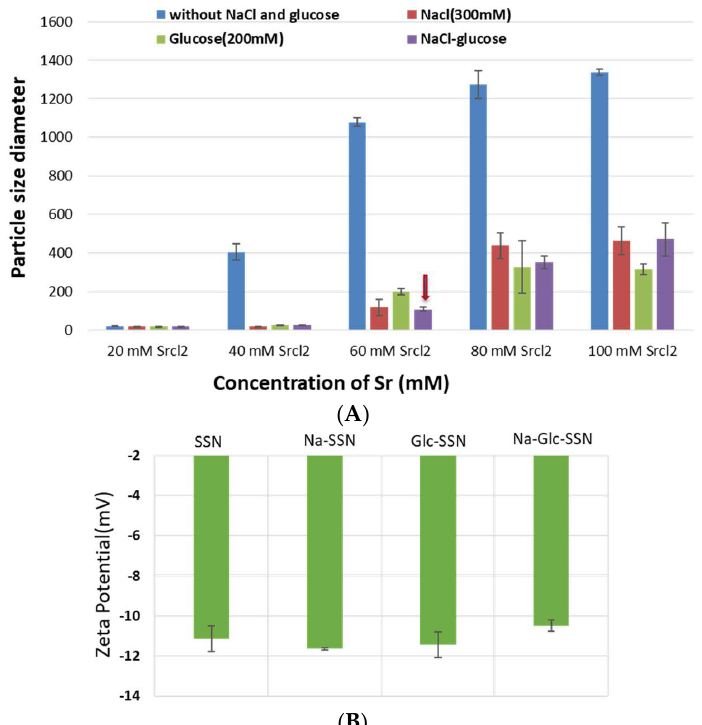
Figure 2. Size ( A ) and zeta potential ( B ) of different strontium sulfite nanoparticles with or without NaCl and glucose. Strontium sulfite nanoparticles were prepared by adding 60 mM of SrCl 2 , 300 mM of NaCl, 200 mM of glucose and fixed amount of Na 2 SO 3 .